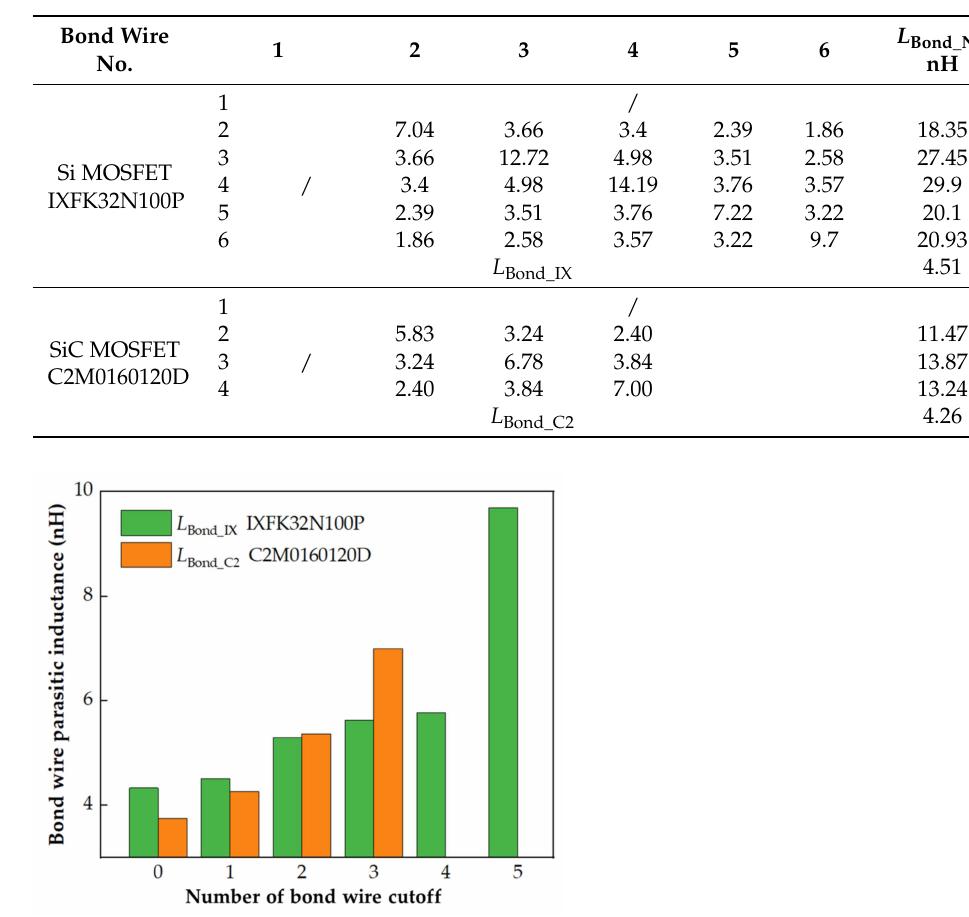
Table 3. Parasitic inductance, L Bond , with one bond wire cutoff.